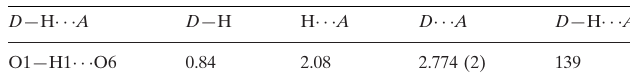
Hydrogen-bond geometry (A˚ , (cid:5)